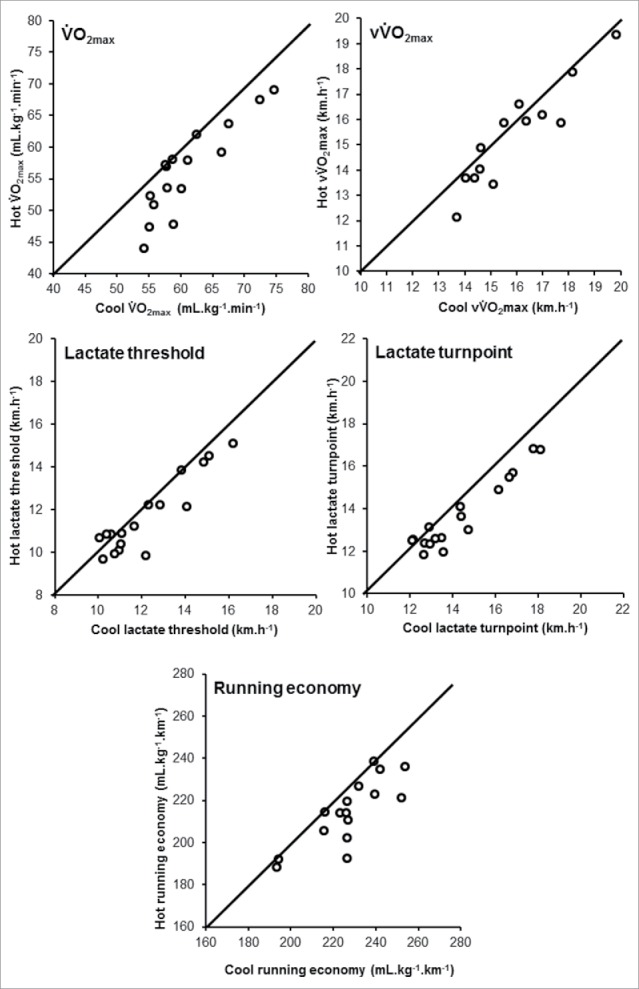
Individual plots demonstrating decrements from heat stress for determinant of endurance performance.